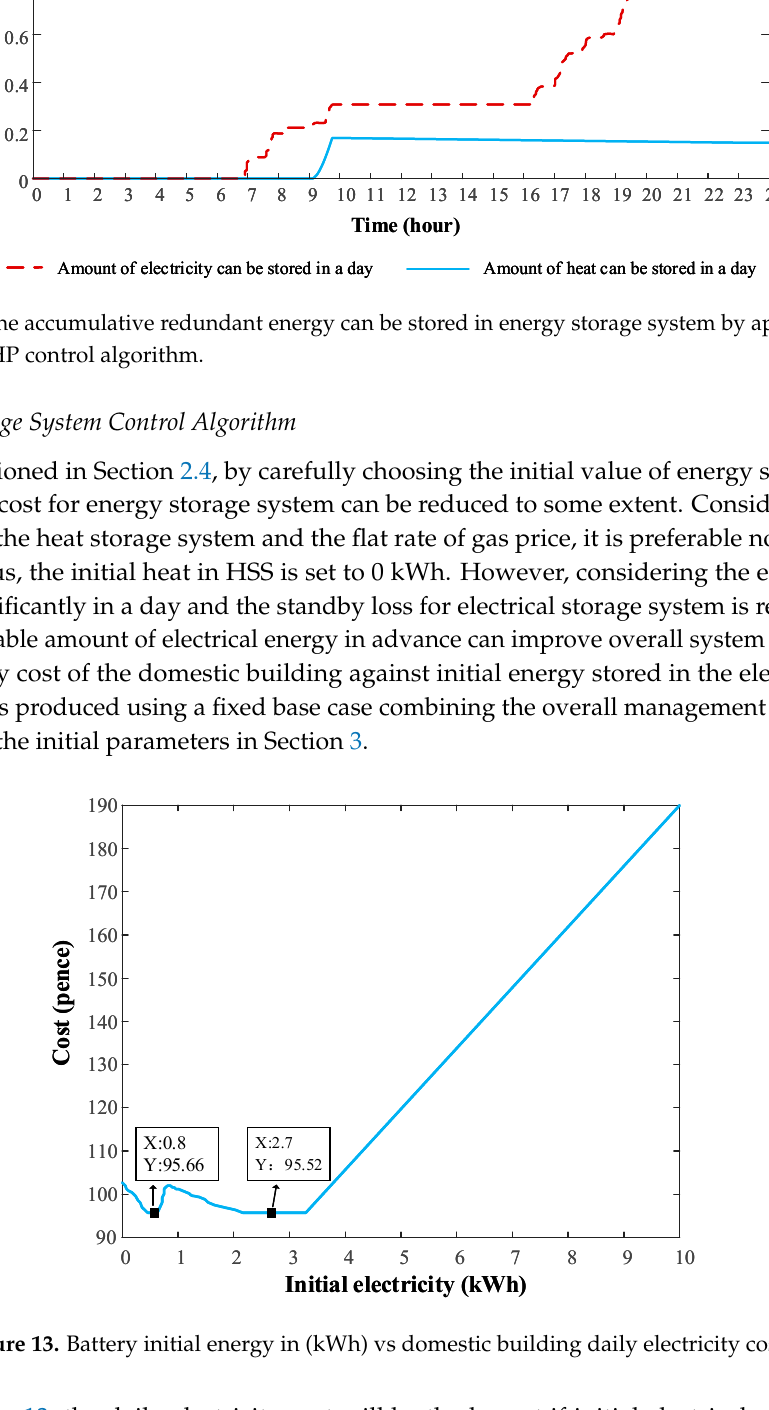
14 of 19 Figure 11. The states of CHP by applying CHP control algorithm and modified CHP control algorithm. Compared to the standard CHP control algorithm, the modified CHP switch algorithm has successfully reduced switching frequency through ‘Fill Gap’ and ‘Remove Glitch’. However, ‘Fill Gap’ and ‘Remove Glitch’ increases system operational cost slightly to 566 pence, which is about 3